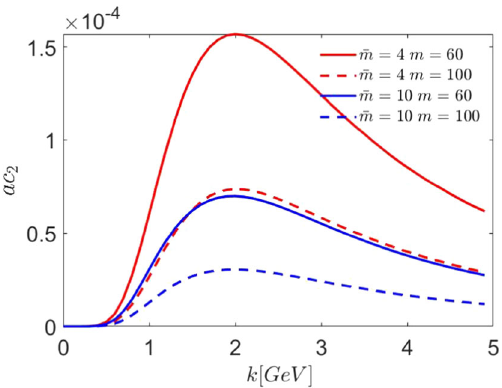
Fig. 12 The form of the ac 2 for k 1 = k 2 = k 3 and for different values of multiplicity m, with ˆ D 0 = 0 . 1, B = 1 GeV − 2 , N c = 3